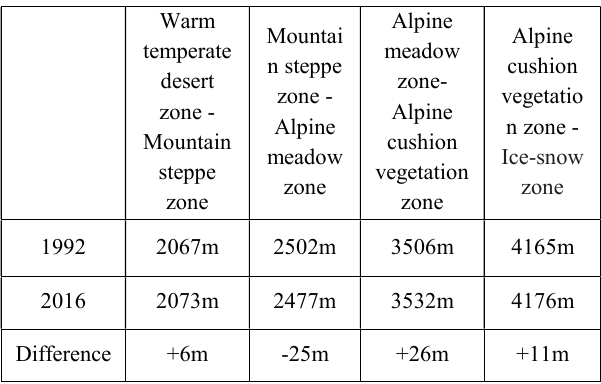
Table 1. Results of demarcation elevation in 1992 and